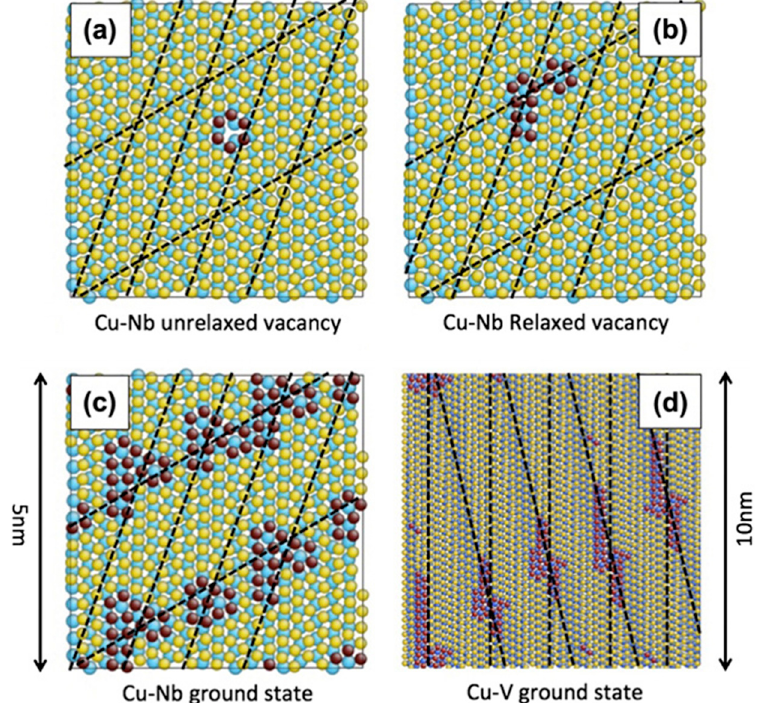
Figure 11. Unrelaxed ( a ) and relaxed ( b ) vacancies on the Cu side of a Cu–Nb interface; ( c ) about 5 at.% constitutional vacancies locates in the ground state Cu–Nb interface; and ( d ) about 0.8 at.% constitutional vacancies locates in the ground state Cu–V interface. Vacancies tend to gather around MDIs. Reprinted with permission from [95]; Copyright 2012 Elsevier.